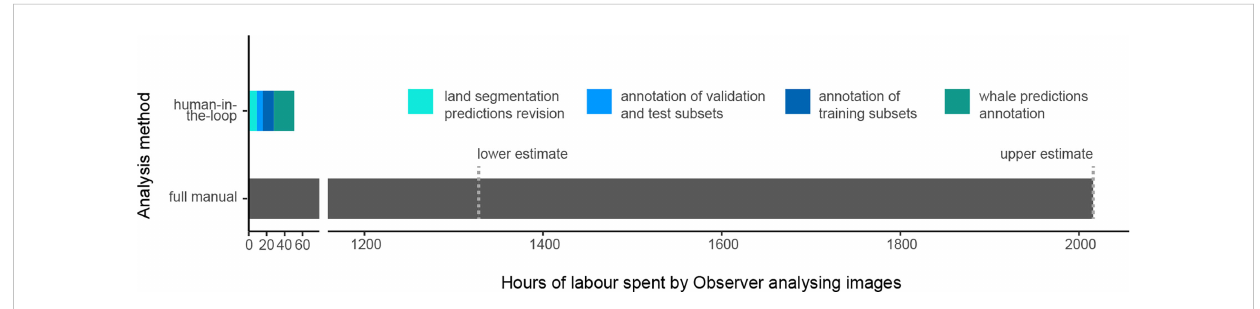
FIGURE 8 Comparison of the time spent by Observer 1 to analyze the dataset with the AI-assisted approach versus the time spent by Observer 3 to analyze the dataset fully by hand. The exact time spent for the full manual analysis was not recorded, hence the lower and upper estimates of the time needed to analyze a dataset of 5334